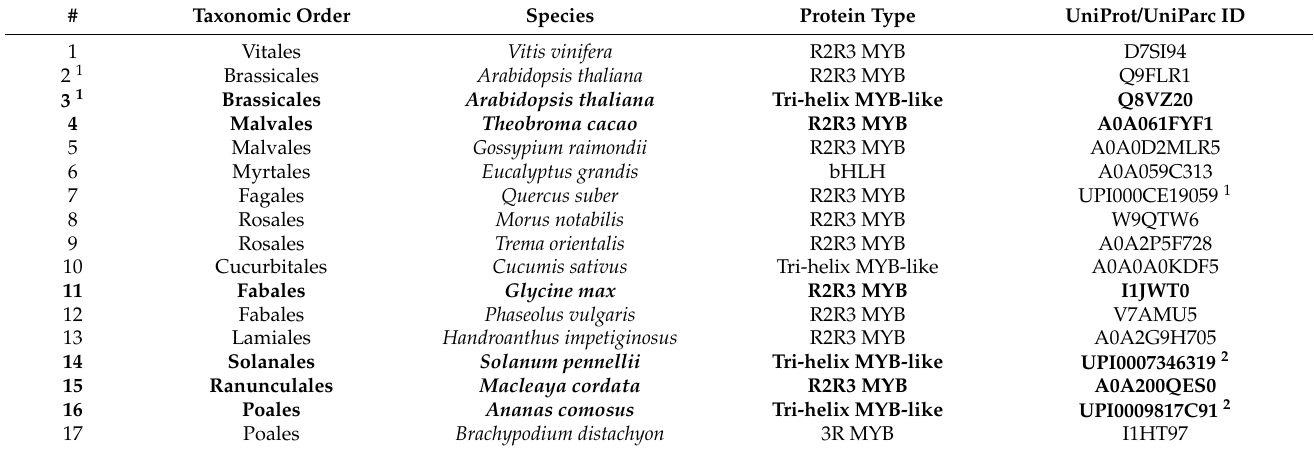
Table 1. Putative MIM-containing proteins outside the Brassicales, and AtMYB29 and AtASR3 (from Figure 1). Bold: selected for further